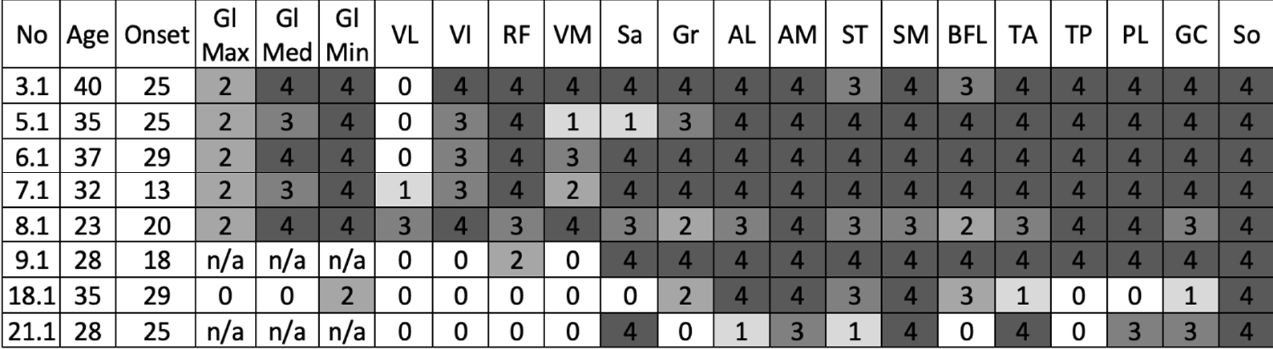
Figure 3. Muscle MRI data in the cohort of GNEM patients. The scores and colors represent the severity of fat infiltration of skeletal muscle according to the scale published by Mercuri et al. [23]